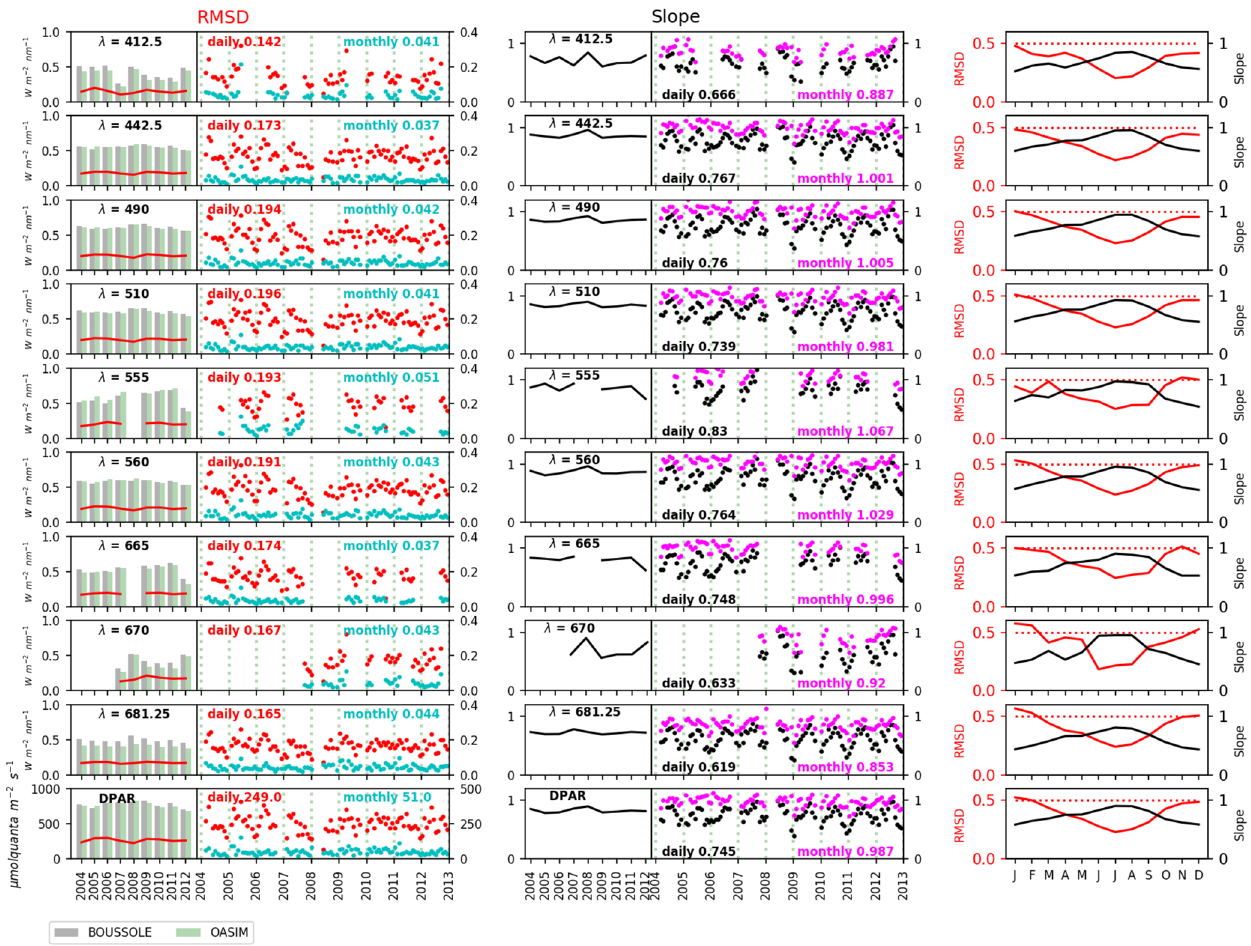
Figure 7. RMSD (left column) and slope (central column) and both indicators (right column) of the relationship between the OASIM and BOUSSOLE downward planar irradiance values ( E d (λ 0 − ) ) at the nine wavelengths ( λ , in nm) and DPAR. The vertical bars in the left panels of each column are the BOUSSOLE (grey) and model (green) annual averages. The RMSD (Wm − 2 nm − 1 ) and the slope (dimensionless) are marked in red and black, respectively, with the lines indicating the annual averages and the dots indicating the monthly averages. The monthly statistics are further separated by filtering out the day-by-day variability and are shown as the cyan dots for the RMSD and fuchsia dots for the slope. The averages over the time series are annotated in the